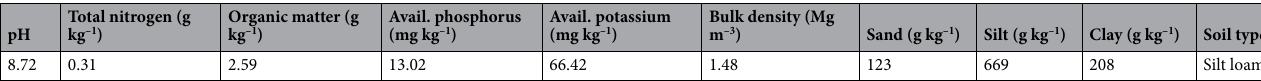
Organic matter (g kg –1